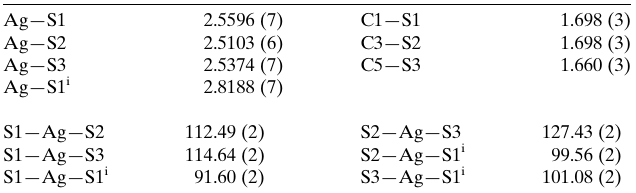
Table 1 Selected geometric parameters (A˚ , (cid:3) ).